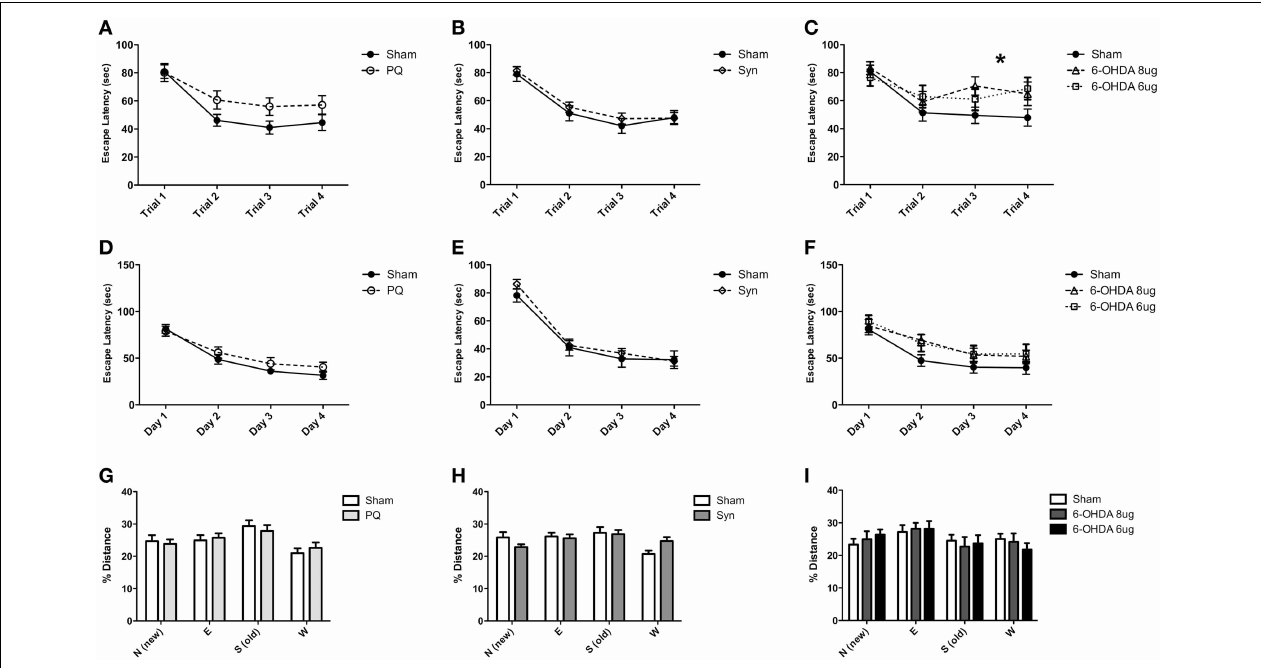
FIGURE 7 | Cognitive behaviors. Animals were challenged with three tasks that differed in their cognitive requirements. Working memory performances of sham and injured animals are compared, PQ (A) , α -syn (B) and 6-OHDA (C) animals. Similarly, spatial reference memory